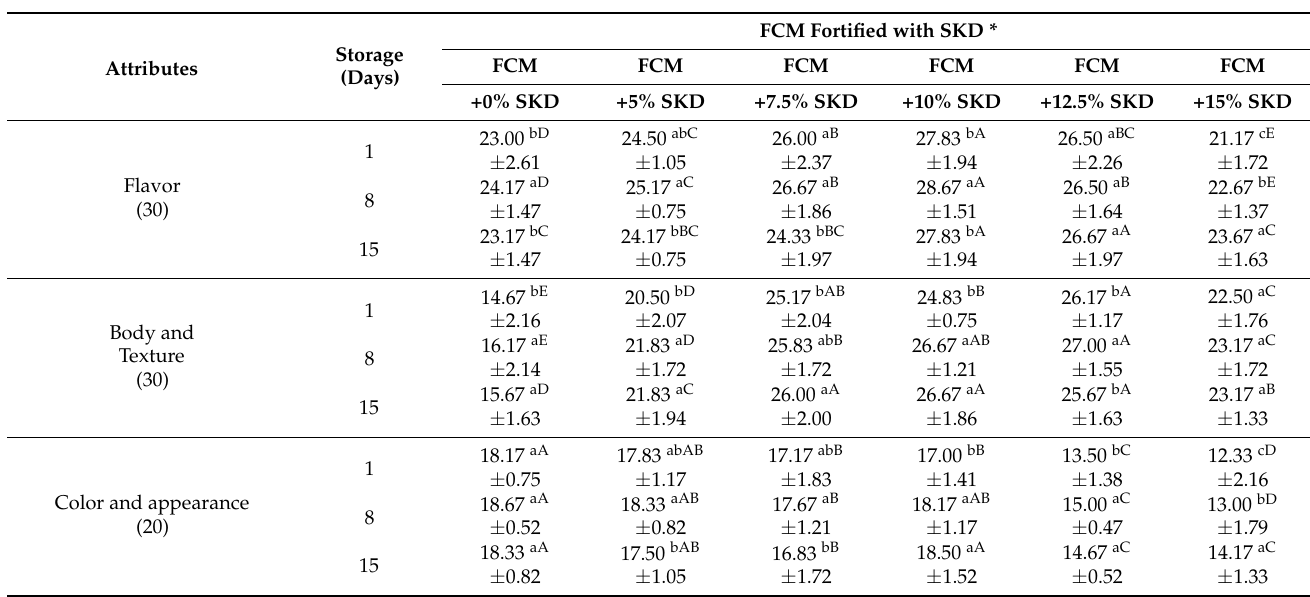
Table 7. Organoleptical attributes of fermented camel milk (FCM) and FCM fortified with date palm (DP) during storage at 4 ◦ C ± 1 ◦ C for 15 days (mean ± SE), n =